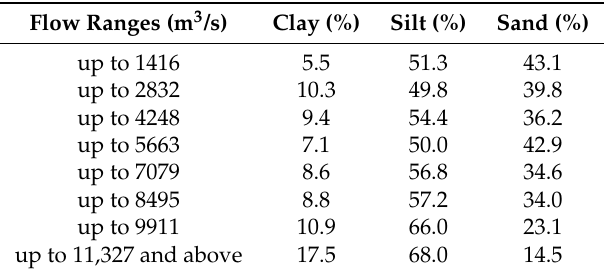
Table 4. Gradation percentages vis-à-vis increasing flow